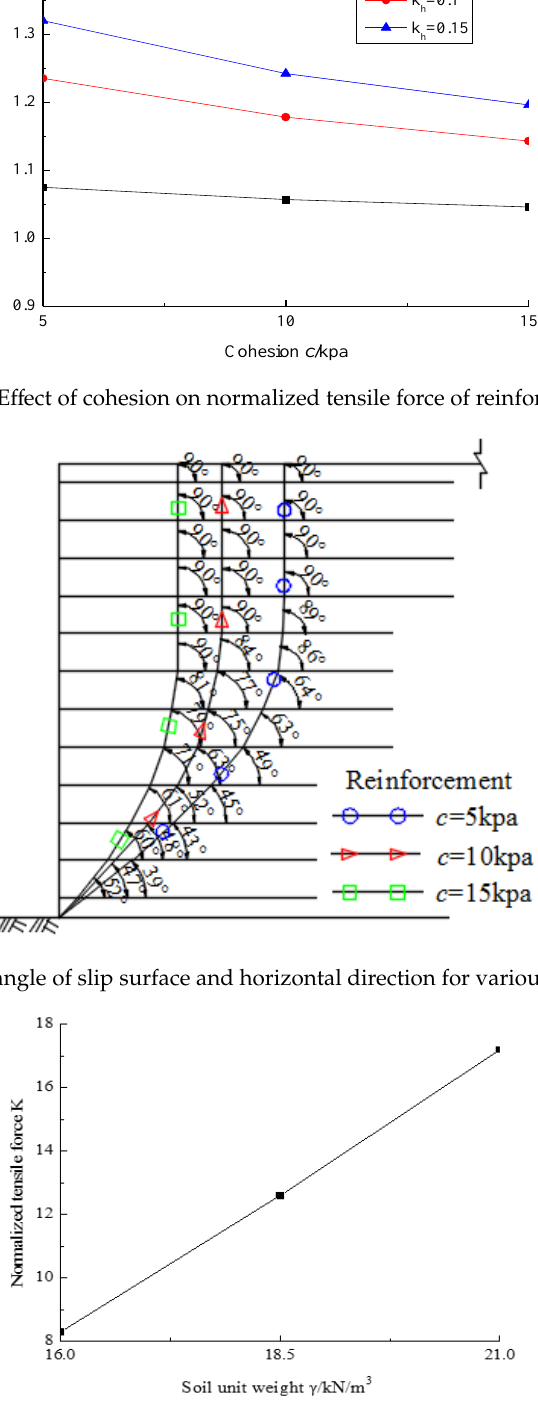
Figure 10. Inclination angle of slip surface and horizontal direction for various unit weights.